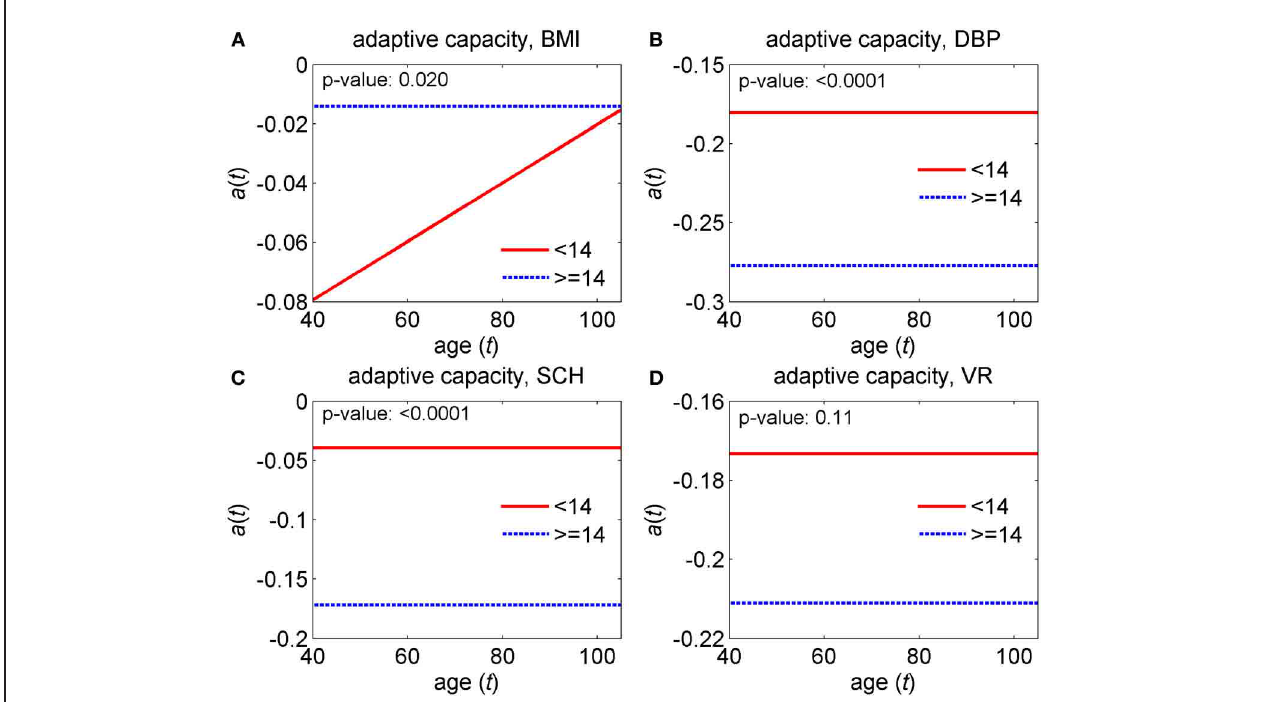
(A) Estimates for body mass index (BMI); (B) estimates for diastolic blood pressure (DBP); (C) estimates for cholesterol (SCH); (D) estimates for ventricular rate (VR). P -values are for the null hypotheses on the equality of adaptive capacities in the two groups. See more details about the model in section “Advanced statistical analyses using the stochastic process